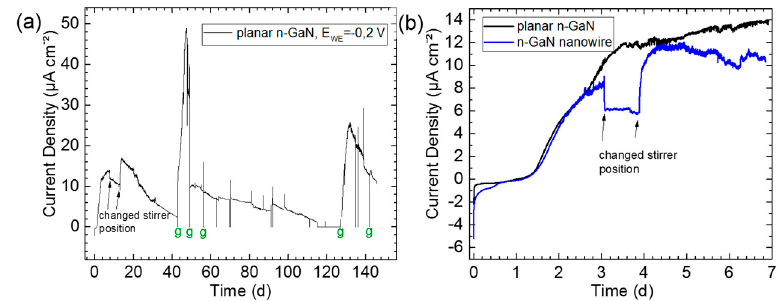
Figure 3. ( a ) Chronoamperogram of biofilms growing on 2D n -type GaN (g: medium exchange); ( b ) Comparison of the initial biofilm growth of planar and nanostructured n